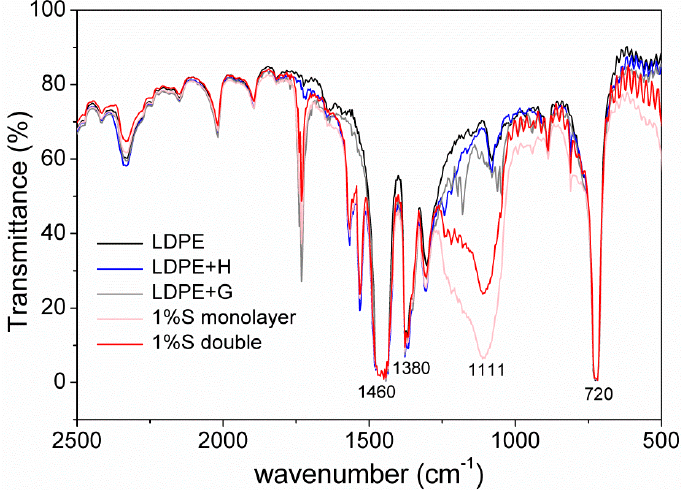
Figure 6. Fourier-transform infrared spectroscopy (FT-IR) spectra of different films.